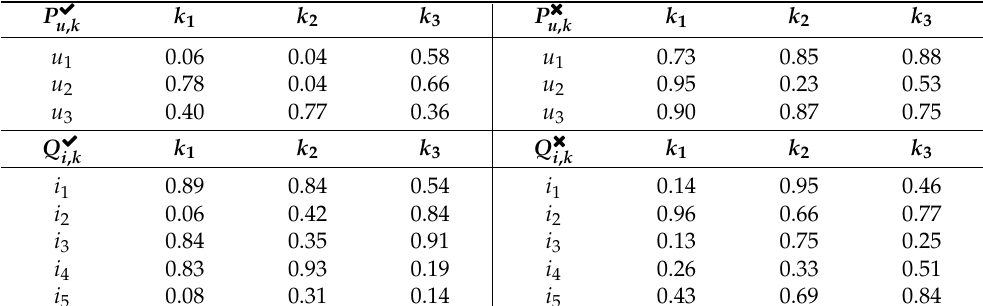
Table 3. Random initialization of K = 3 latent factors for both users P and items Q . P ¸ u ,